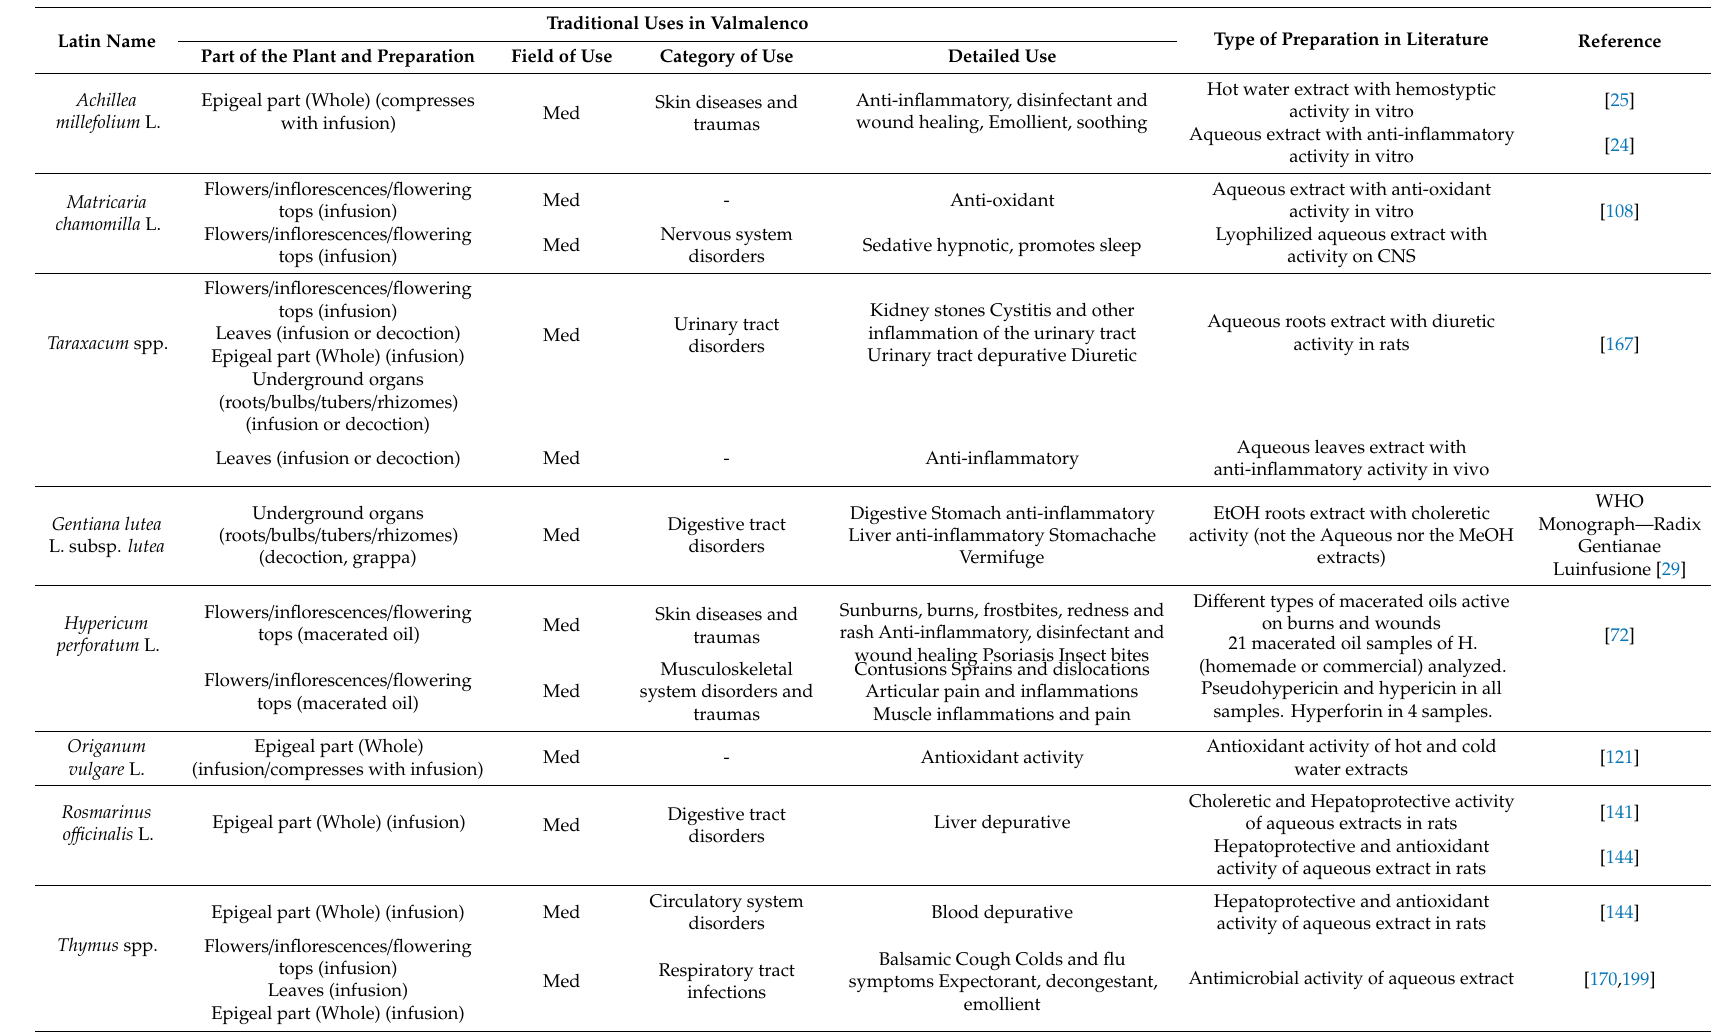
Table 4. Comparable extracts mentioned in literature with the traditional